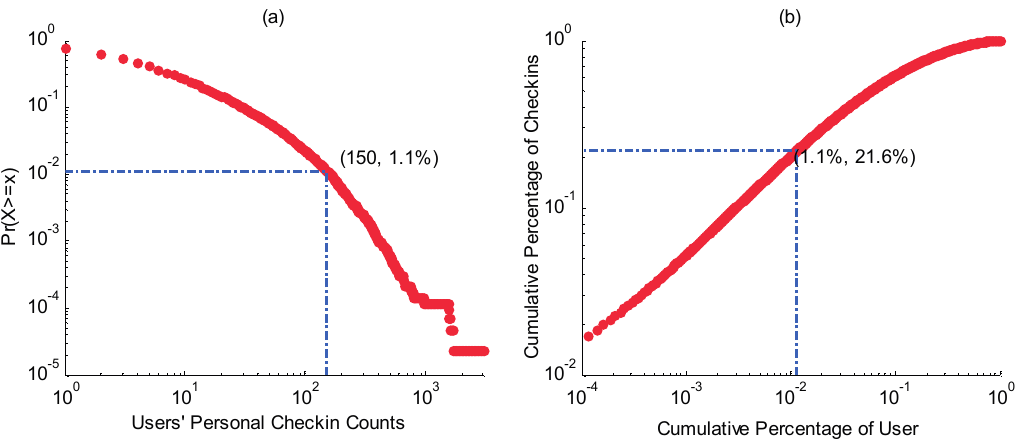
Figure 1. Cumulative distribution function (CDF) of user’s personal check-in counts ( a ) and users’ cumulative contributions to the check-in dataset ( b